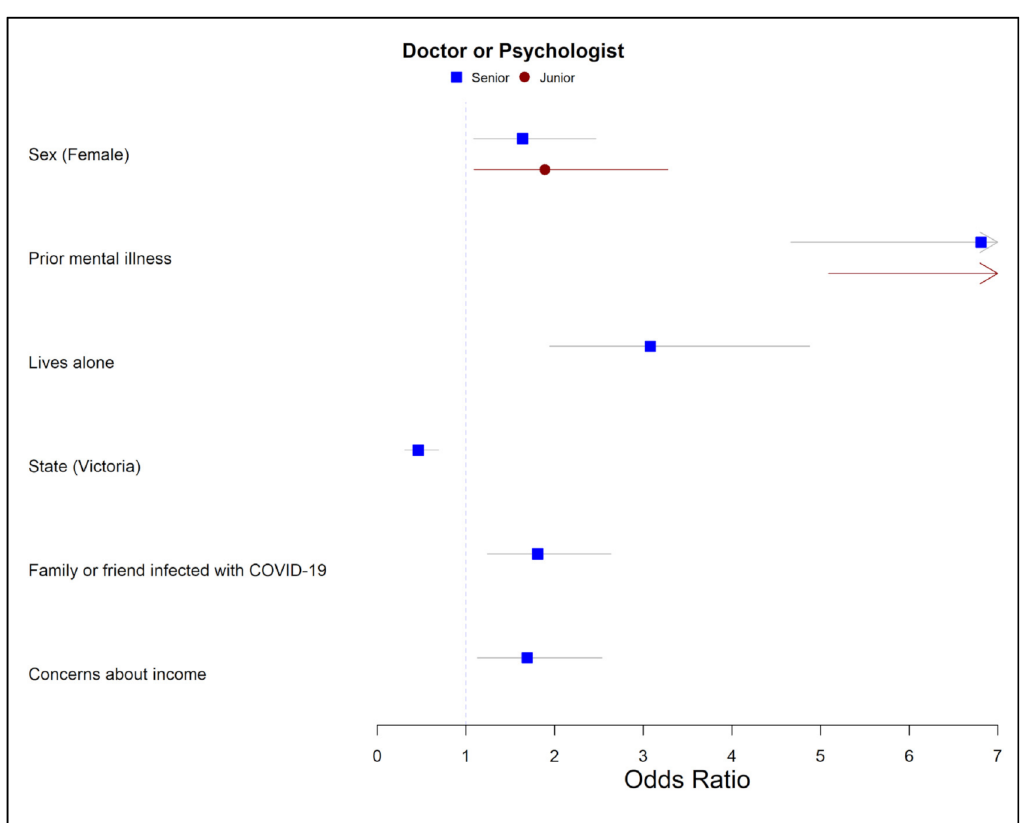
Figure 2. Personal and workplace predictors of seeking help from a doctor or psychologist for junior and senior medical staff. Red circle = junior, blue square = senior. Lines represent odds ratio and 95% confidence intervals. Reference categories: female vs. male, prior mental illness vs. none, lives alone vs. with others, Victoria vs. other states, family or friend infected with COVID-19 vs. negative response, concerns about income vs. negative